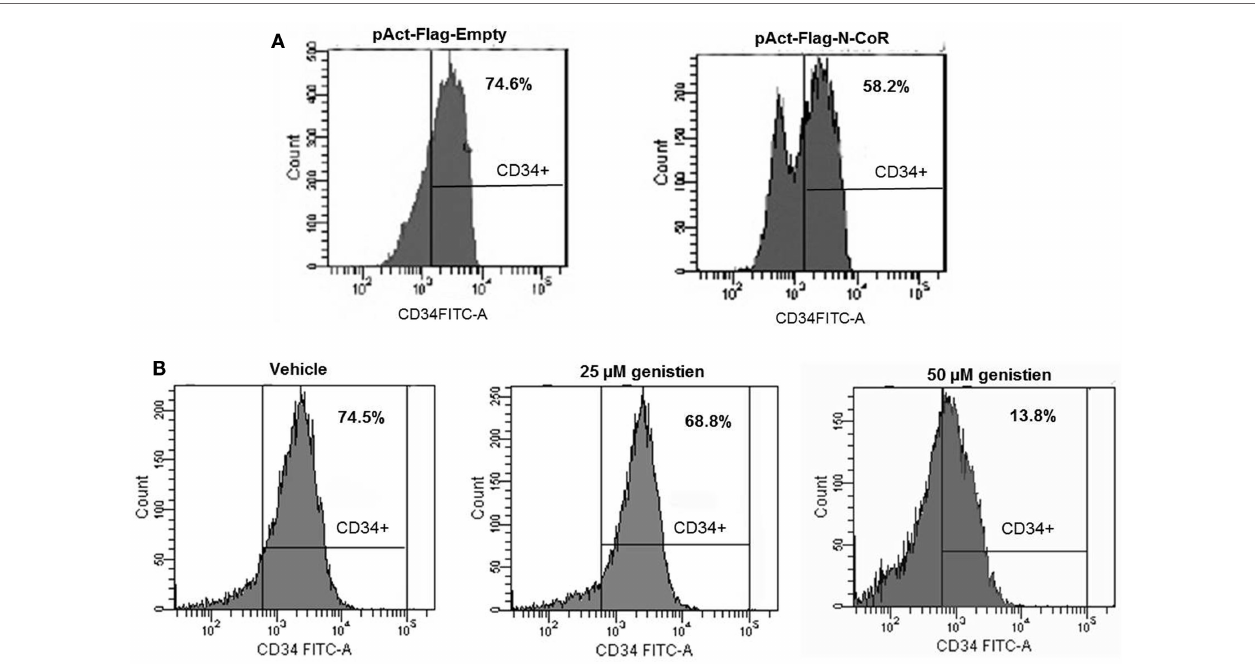
FigUre 6 | native n-cor down regulates the cD34 positivity in monocytic aMl cells . (a) Ectopic overexpression of N-CoR in THP-1 cells reduced the CD34 + positivity as determined by flow cytometry. (B) Genistein decreased the percentage of CD34 + positivity of THP-1 cells in a dose-dependent